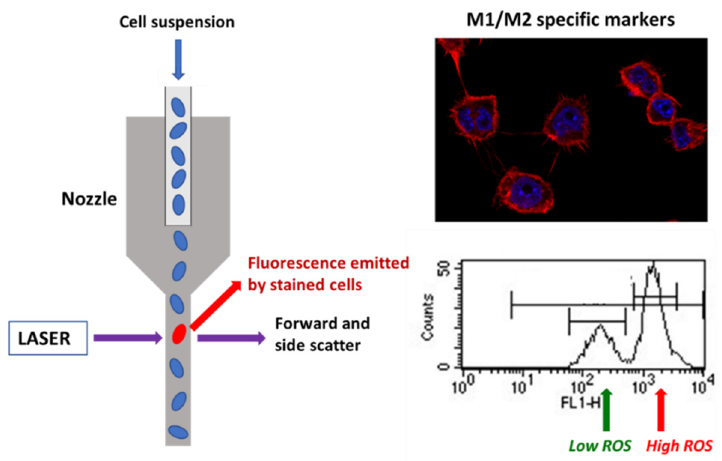
Scheme 1. Evaluation of different specific markers of M1 and M2 macrophage phenotypes by flow cytometry and confocal microscopy after contact of RAW-264.7 macrophages with